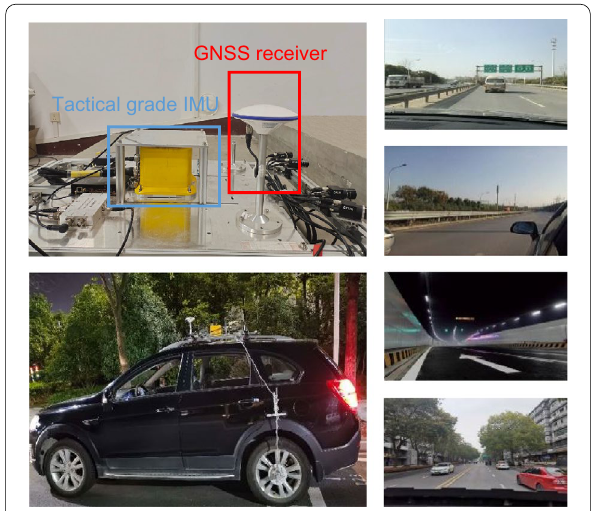
Fig. 6 Experimental equipment and typical scenes of vehicle